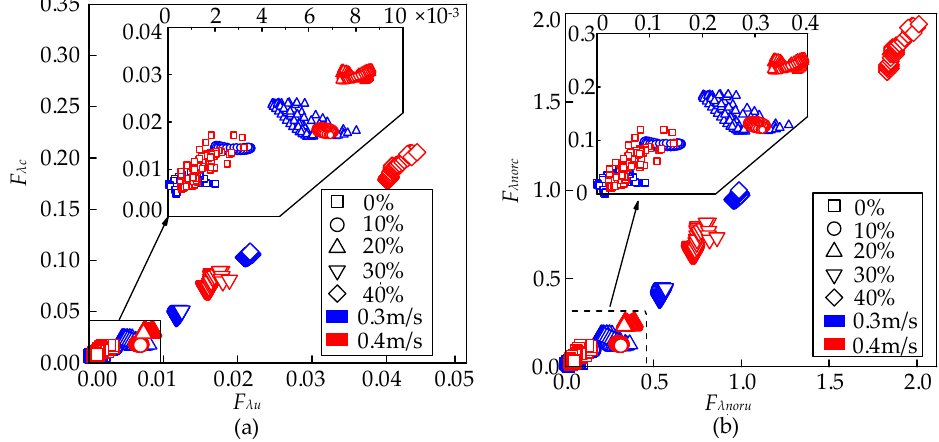
Figure 17. The distribution of the fault samples normalized by the RCQFFV: ( a ) Original fault samples; ( b ) Normalized fault samples.